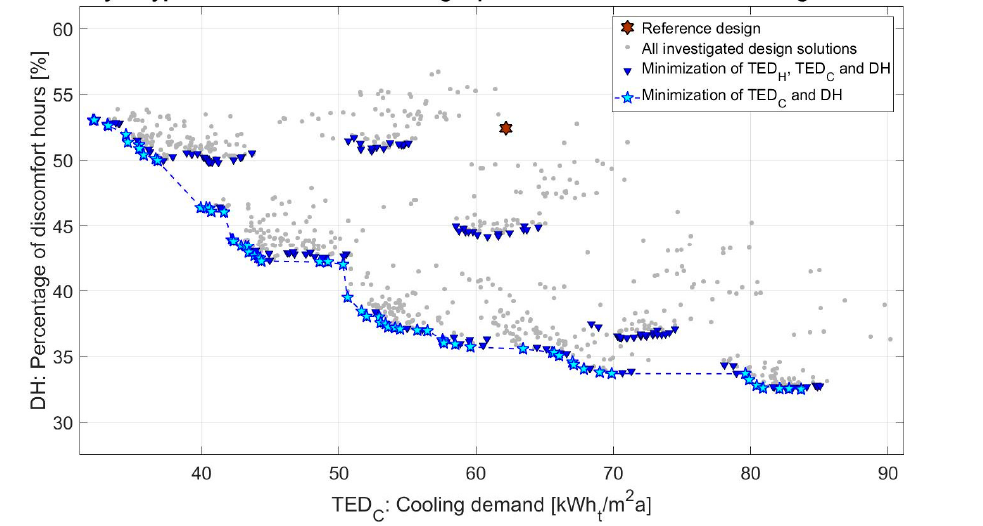
Figure 8. 2D Pareto front TED cool –DH